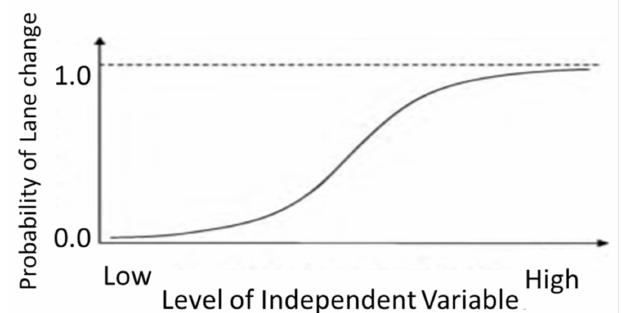
Figure 1. Logistic relationship between lane changing probability and independent